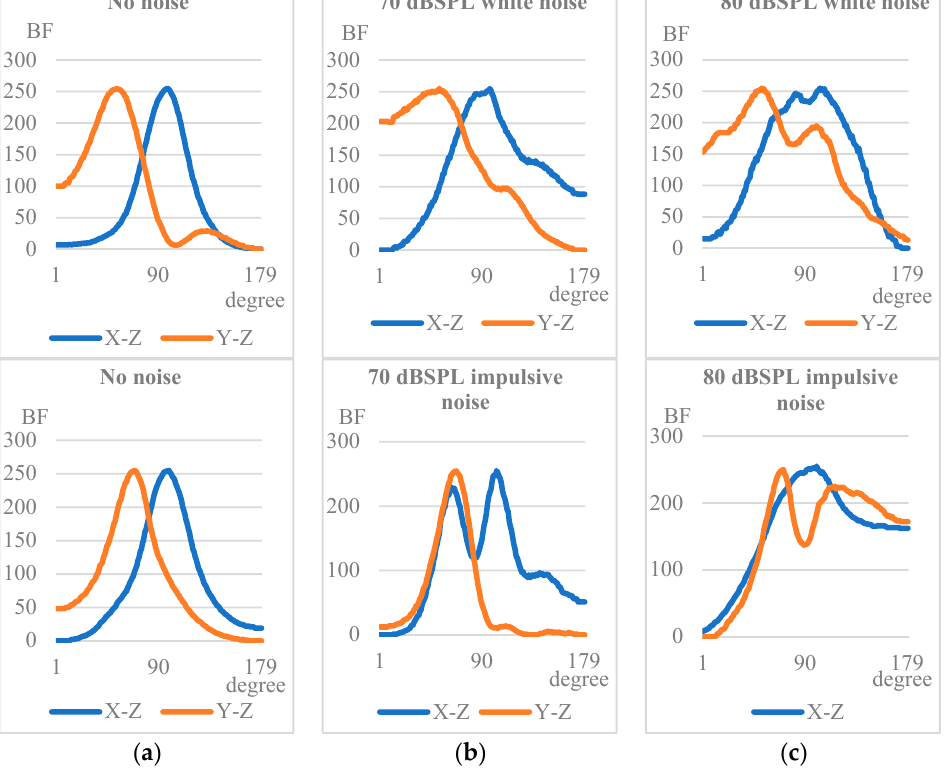
Figure 9. The results of proposed beamforming engine with background ambient white noise ( top ) and impulsive sound (bottom): ( a ) Degree of beamforming results under 40 dB background noise, ( b ) degree of beamforming results about 70 dB background noise, and ( c ) degree of beamforming results over 80 dB background noise. Here, X-Z is θ xz between the x and z axis, and Y-Z is θ yz between y and z axis as shown in Figure 1.